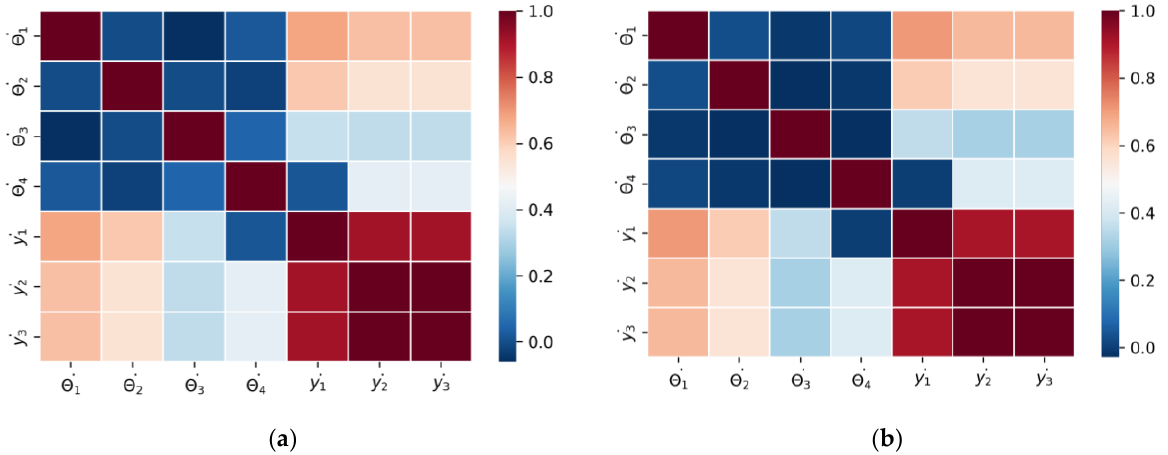
Figure 9. Pearson’s coefficients heat map correlations for the systems that use sodium thiosulfate as leaching agent without Hg removal ( a ) and with Hg removal ( b